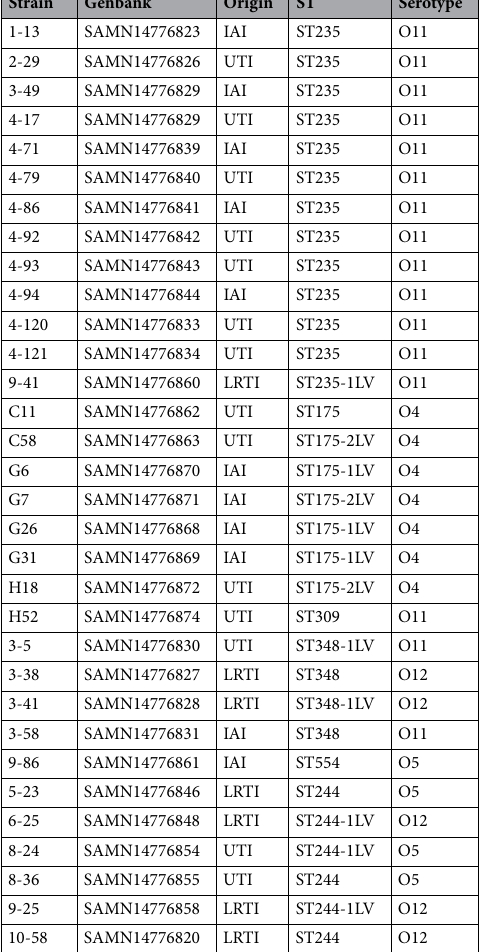
Table 1. Characteristics of the 32 clinical isolates of P. aeruginosa which were obtained in previous study 30 . It is indicated each Genbank code, clinical origin, sequence type (ST) and serotype. IAI intra-abdominal infection, UTI urinary tract infection, LRTI lower respiratory tract